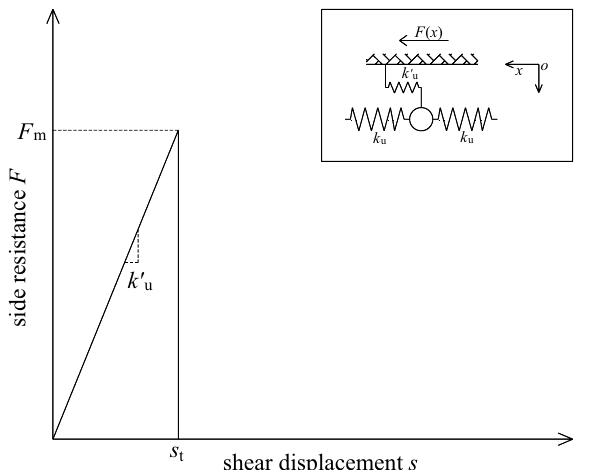
Figure 13. Schematic diagram of spring